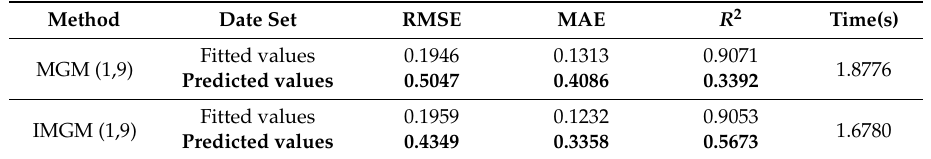
Table 6. Comparison of forecasting evaluation indexes of MGM (1,9) and IMGM (1,9) for the vibration signal.